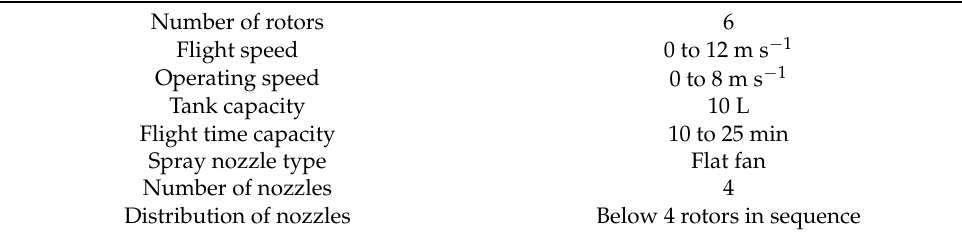
Table 1. Specifications of the UAV DJI Agras MG-1P.